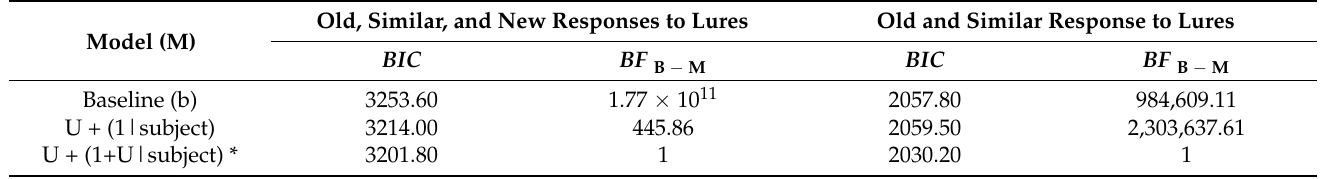
Table 3. Generalized linear mixed-effects model comparison in Experiment